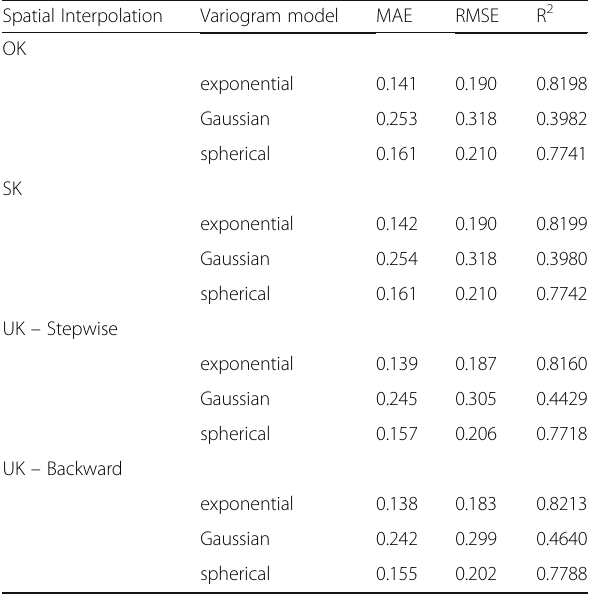
Table 6 Cross validation of OK, SK, and UK applying exponential, Gaussian, and spherical variogram models applied to Sand texture fraction Spatial Interpolation